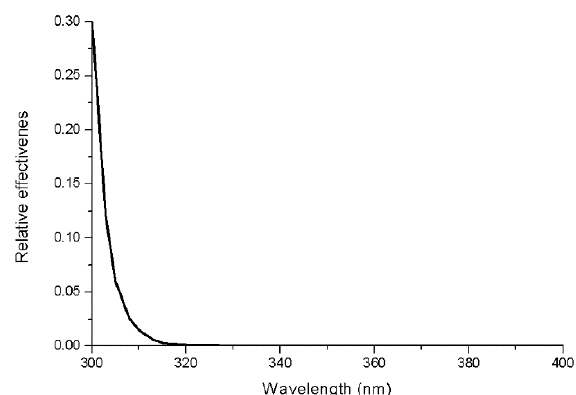
Figure 3. Skin damage action spectra [35].